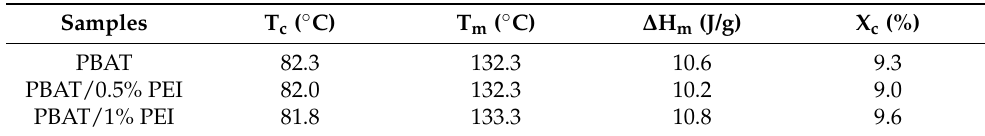
Figure 3. DSC curves for PBAT and PBAT/PEI films. (( a ) Crystallization curve, ( b ) melting curve, the second heating). Table 4. DSC results of PBAT and PBAT/PEI